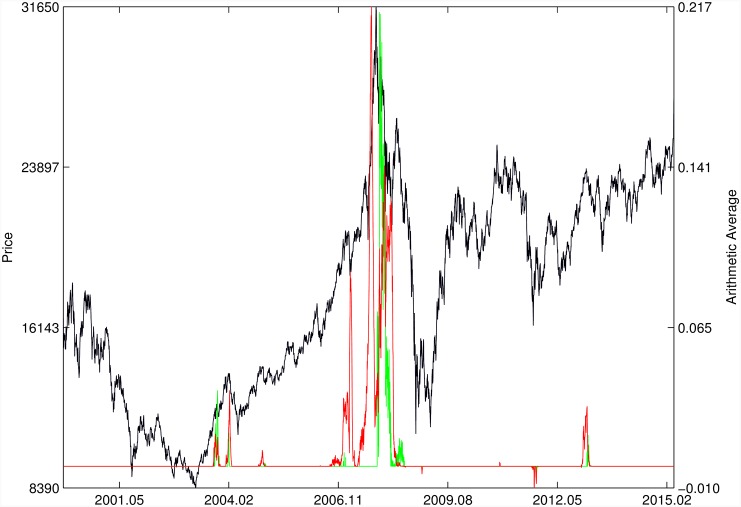
Hong Kong 2007.Same as Fig 10.